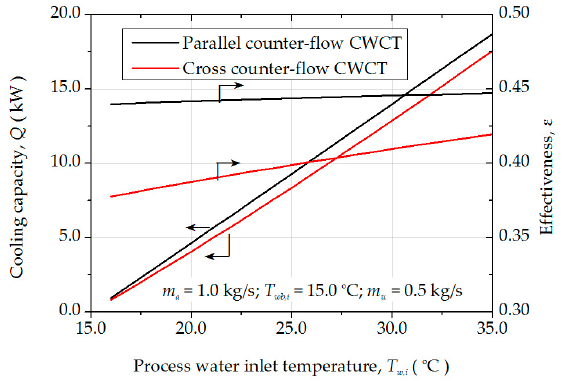
Figure 6. Cooling capacity and cooling tower effectiveness versus process water inlet temperature (the arrows indicate the variable axis).